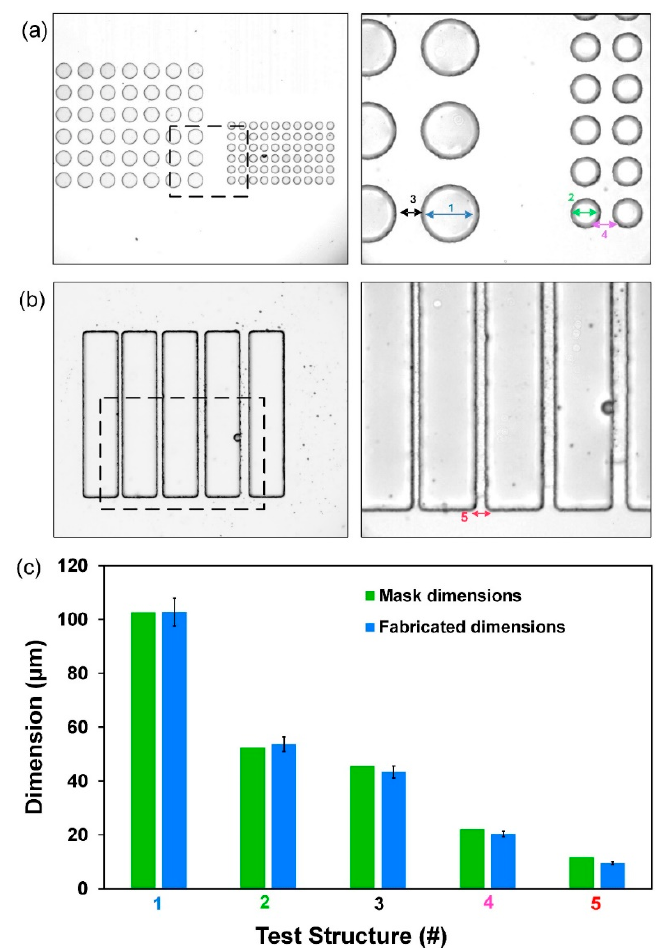
Figure 4. PDMS replicas of test structures in ADEX resist to test resolution, accuracy and adhesion. Dimensions are those commonly used in microfluidic devices for biomedical applications. ( a ) Circular pillar arrays of diameter 100 µm (Test Structure 1) and 50 µm (Test Structure 2), separated by 45 µm (Test Structure 3) and 20 µm (Test Structure 4) gaps; ( b ) rectangular pillar array separated by 10, 15 (Test Structure 5), 20 and 25 µm gaps; and ( c ) comparison of dimensions in the high-resolution mask vs. fabricated features in dry film ( n = 25).